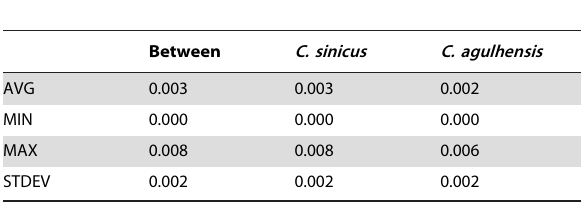
Table 6. K2P distances between and among C. sinicus and C. agulhensis based on